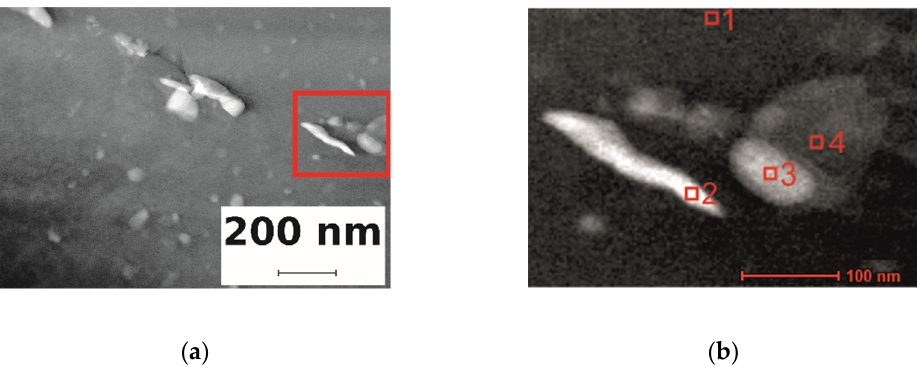
Figure 2. Transverse cross-sectional HAADF STEM micrographs of SPSed AA7075 ( a , b ). Table 2. Chemical composition of precipitates in various areas presented in Figure 2b. Element